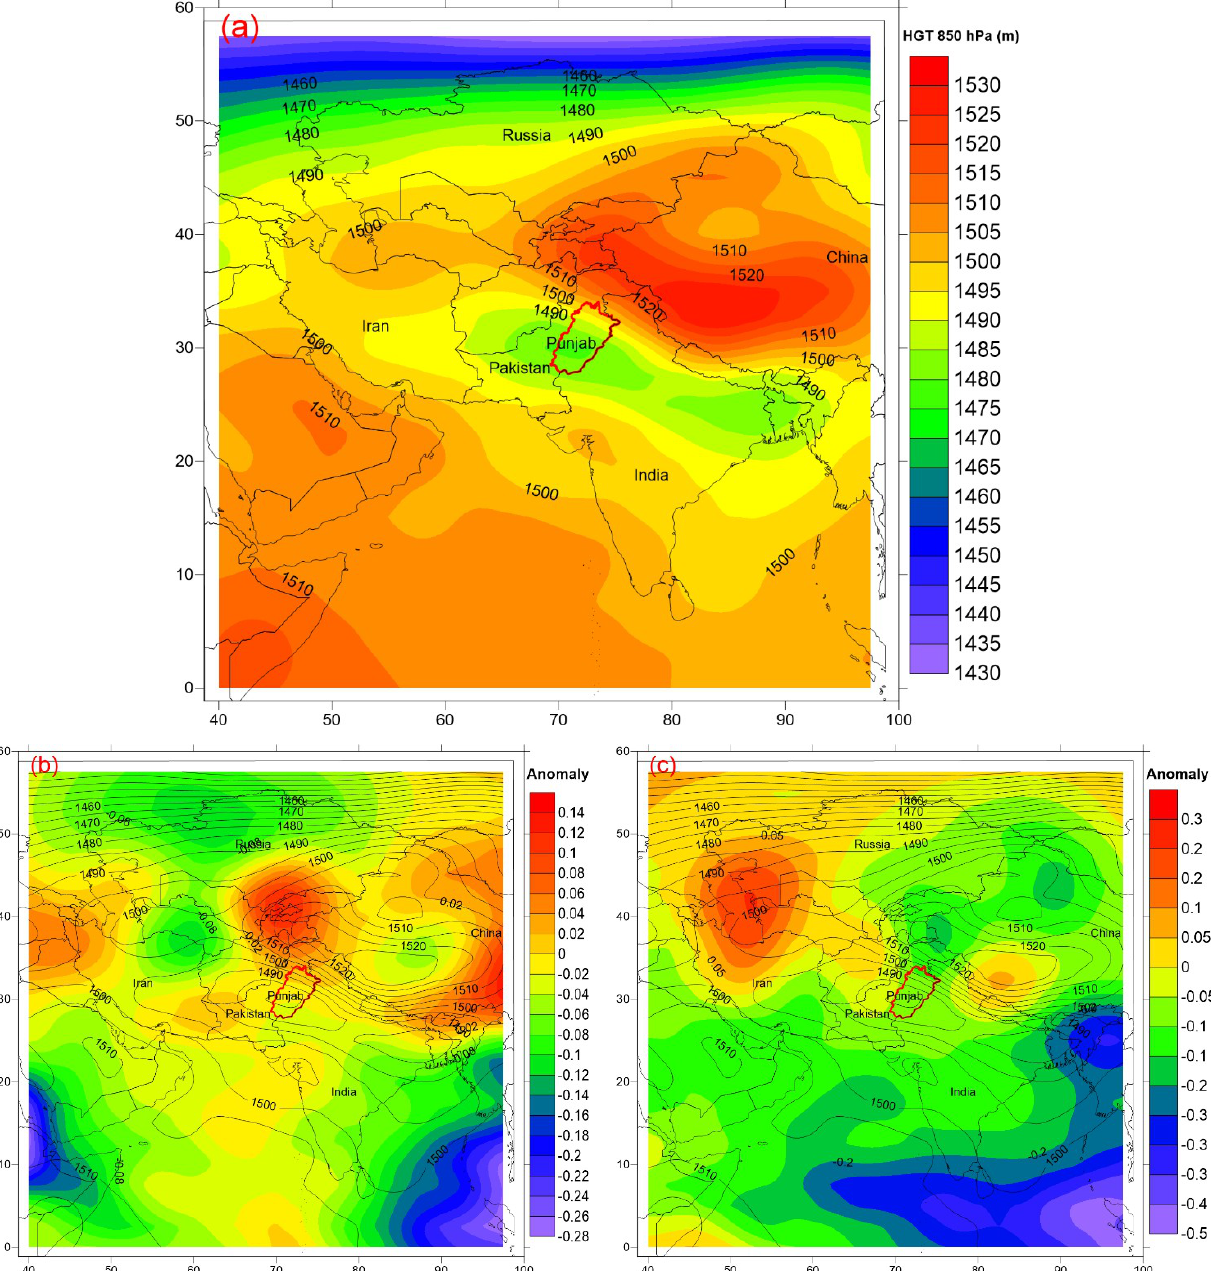
Figure 9. Average of the 850 hPa HGT during different periods in Punjab, Pakistan: ( a ) average of the 850 hPa HGT during 1979–2014, ( b ) average of the 850 hPa HGT during 1979–2014 (contour) and the anomaly of the 850 hPa HGT for the dry period (1999–2003) (shaded), and ( c ) average of the 850 hPa HGT during 1979–2014 (contour) and the anomaly of the 850 hPa HGT for the wet period (2011–2014) (shaded).